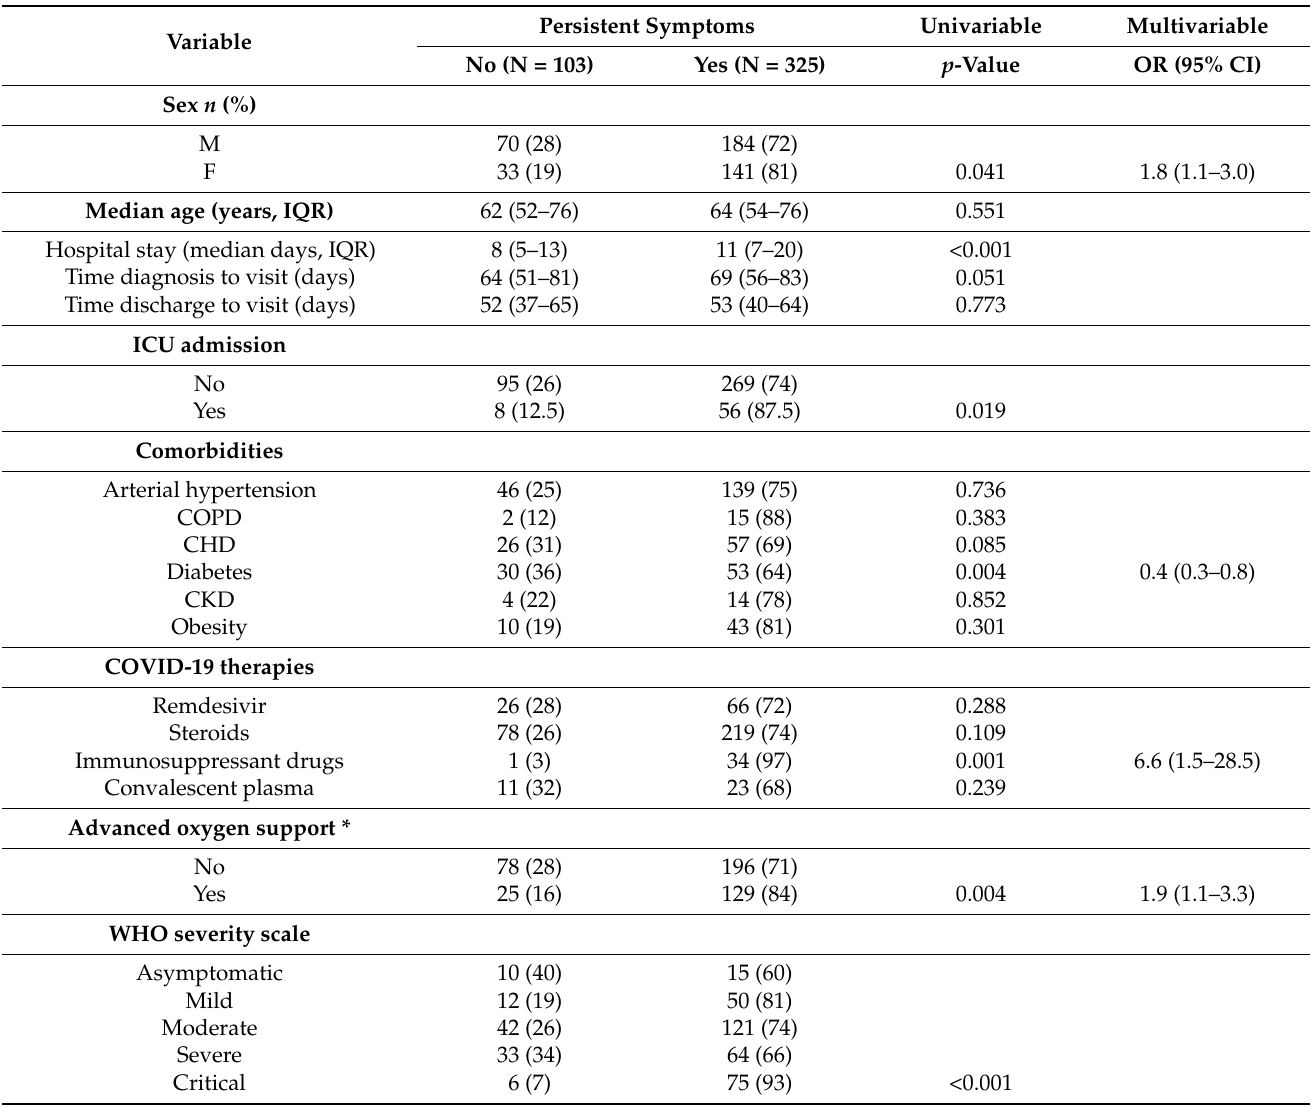
Table 2. Risk factors for long COVID persistent symptoms in a cohort of 428 patients evaluated at the Careggi University Hospital (Florence, Italy) 4–12 weeks after hospitalization for COVID-19,